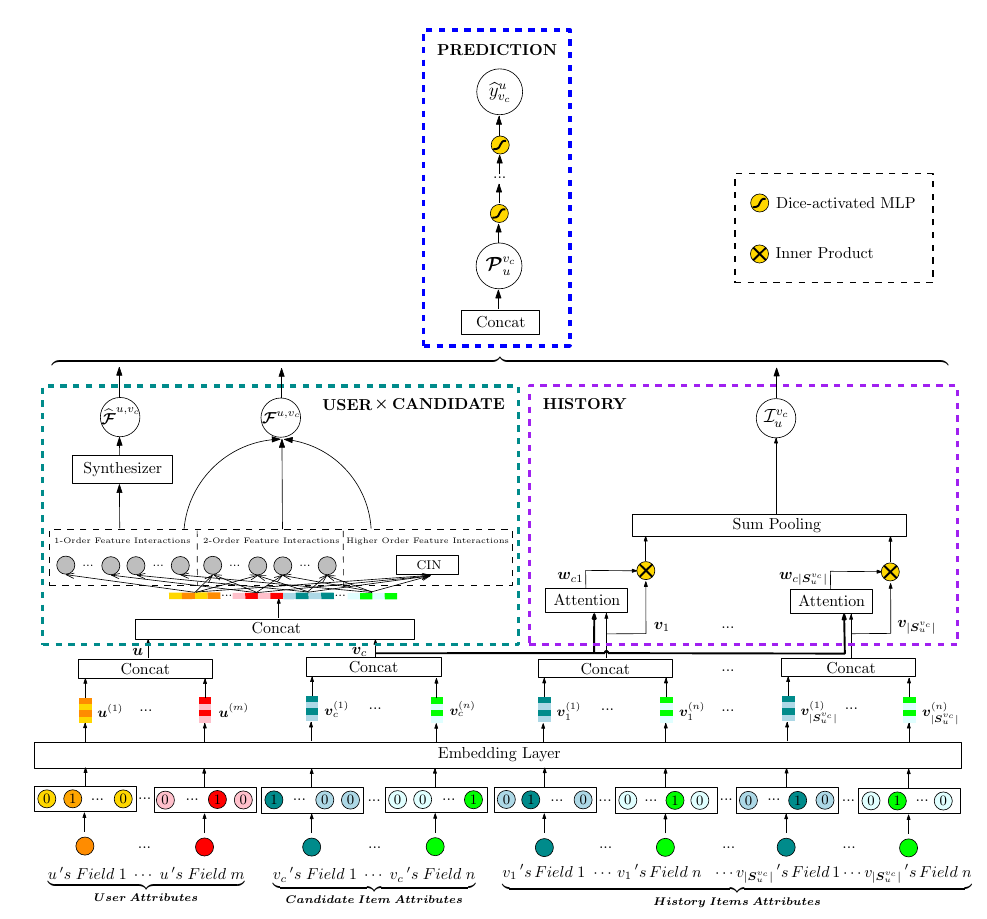
Figure 1. ALIEN architecture. The dark-green dashed box on the left side illustrates the attributes-driven latent information extraction layer (USER × CANDIDATE); the purple dashed box on the right, the user behavior-driven latent information extraction layer (HISTORY); and the blue dashed box at the top, the latent information digestion and prediction layer